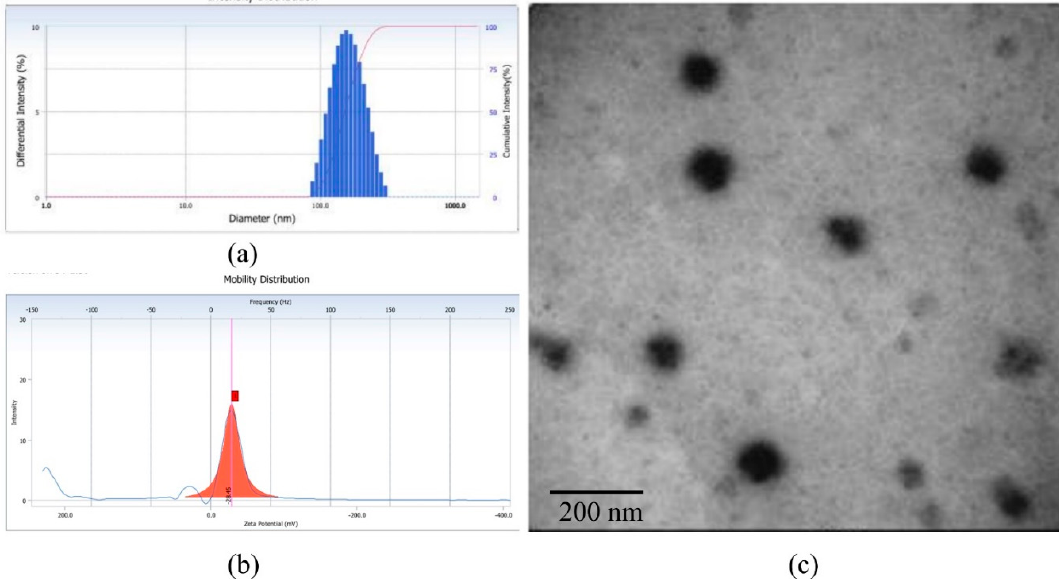
Figure 4. The size ( a ), zeta potential ( b ), and TEM image ( c ) of AP-PP-DOX